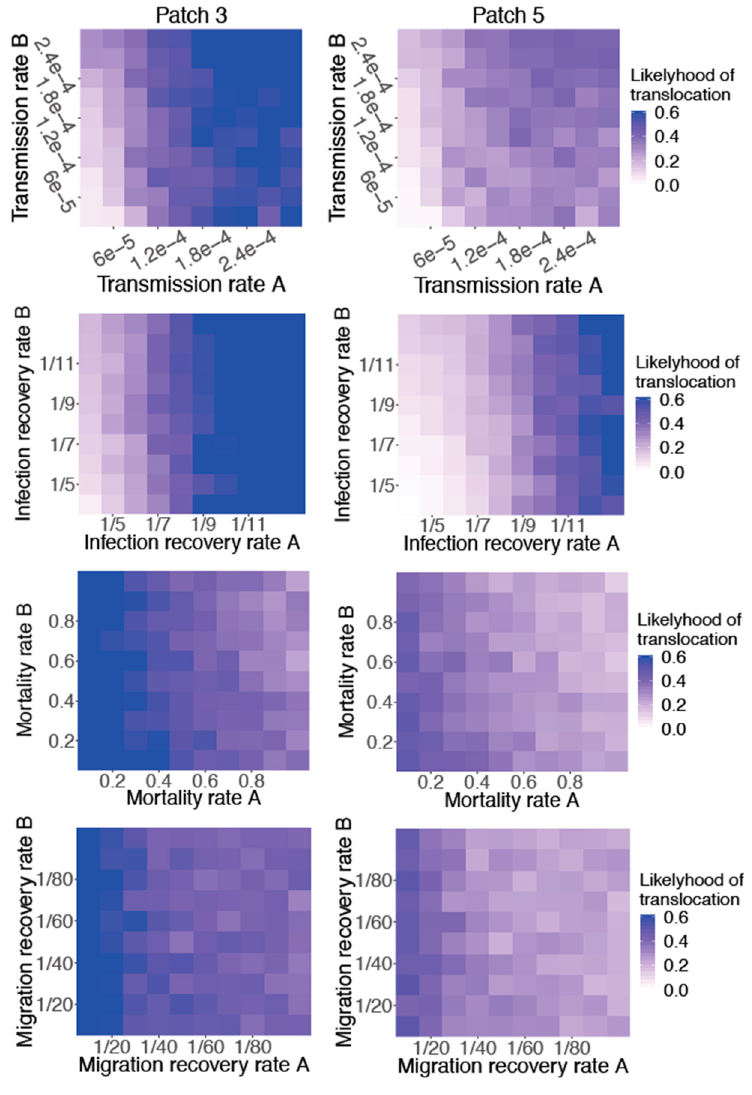
Figure 2. The likelihood of virus translocation to Patch 3 and Patch 5 as a function of the four core parameters in Flock A (the seeded flock) and Flock B (the susceptible flock). The likelihood of reaching Patch 3 or Patch 5 is quantified as the fraction of runs (of 100 stochastic simulations) for which the virus does not go extinct before reaching that patch.